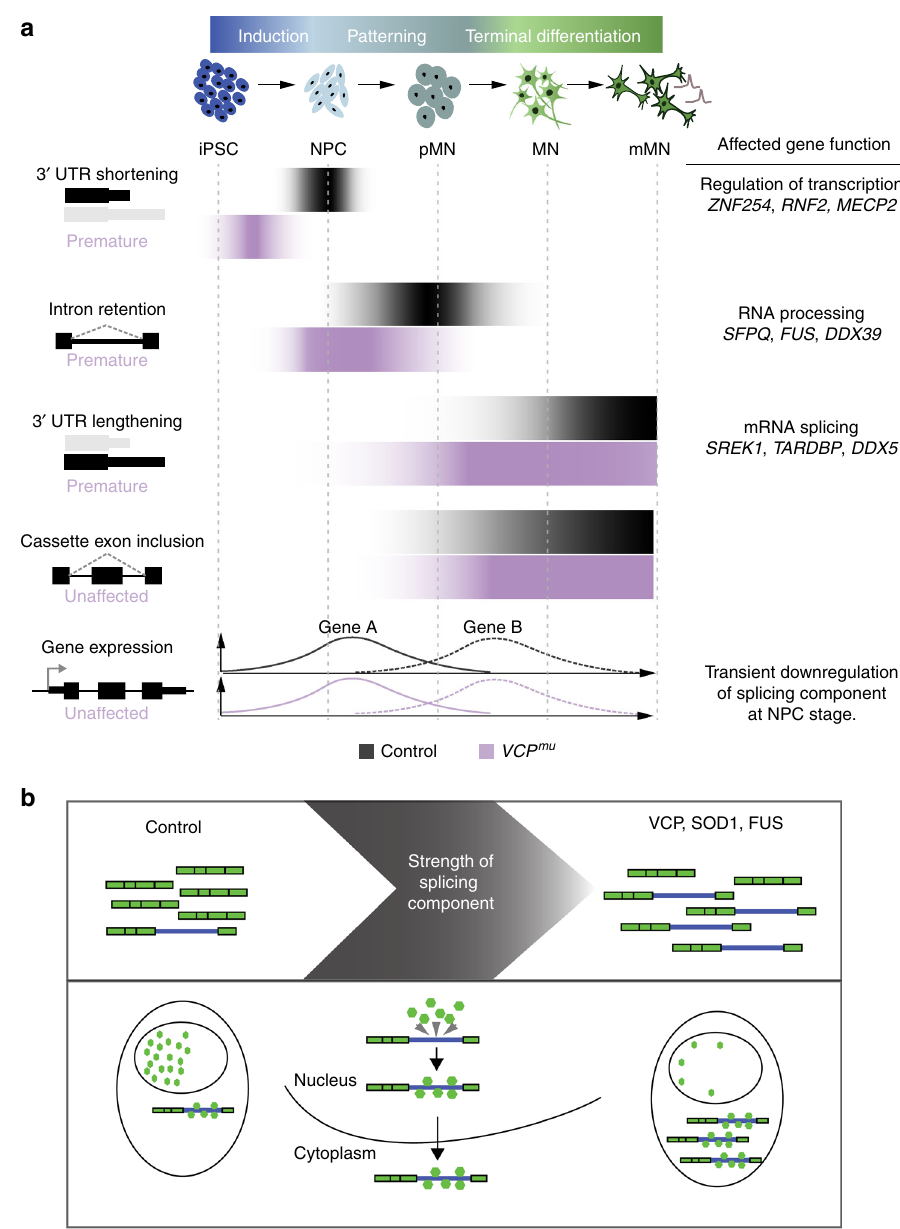
Fig. 7 Schematic diagram of proposed model. a Cartoon summarising the time course of post-transcriptional events underlying human motor neurogenesis in control and VCP mu samples. Our results suggest that the predominant RNA-processing events at an early stage of neural differentiation are IR and 3 ′ UTR remodelling. These events start prematurely in VCP mu samples but do not affect major transcriptional programmes underlying human MN differentiation. b Cartoon summarising the functional consequence of aberrant IR in SFPQ gene across diverse genetic and sporadic forms of ALS. The 9 kb intron 9/9 in SFPQ is retained across all ALS-mutant backgrounds, which leads to increased cytoplasmic abundance of affected transcripts. The SFPQ protein binds extensively to the retained intron. The SFPQ protein itself is relocalised from the nucleus to the cytoplasm in all ALS-mutant backgrounds, as well as post-mortem samples of sporadic ALS